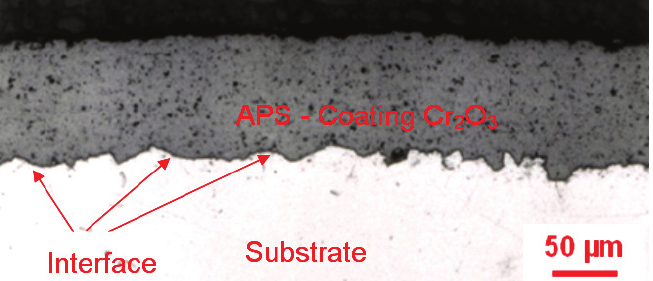
Figure 5 – Cr 2 O 3 coating microstructure deposited from a distance of 110mm Рис . 5 – Микроструктура покрытия Cr 2 O 3, нанесенного с расстояния 110 мм Слика 5 – Микроструктура Cr 2 O 3 превлаке са одстојањем 110